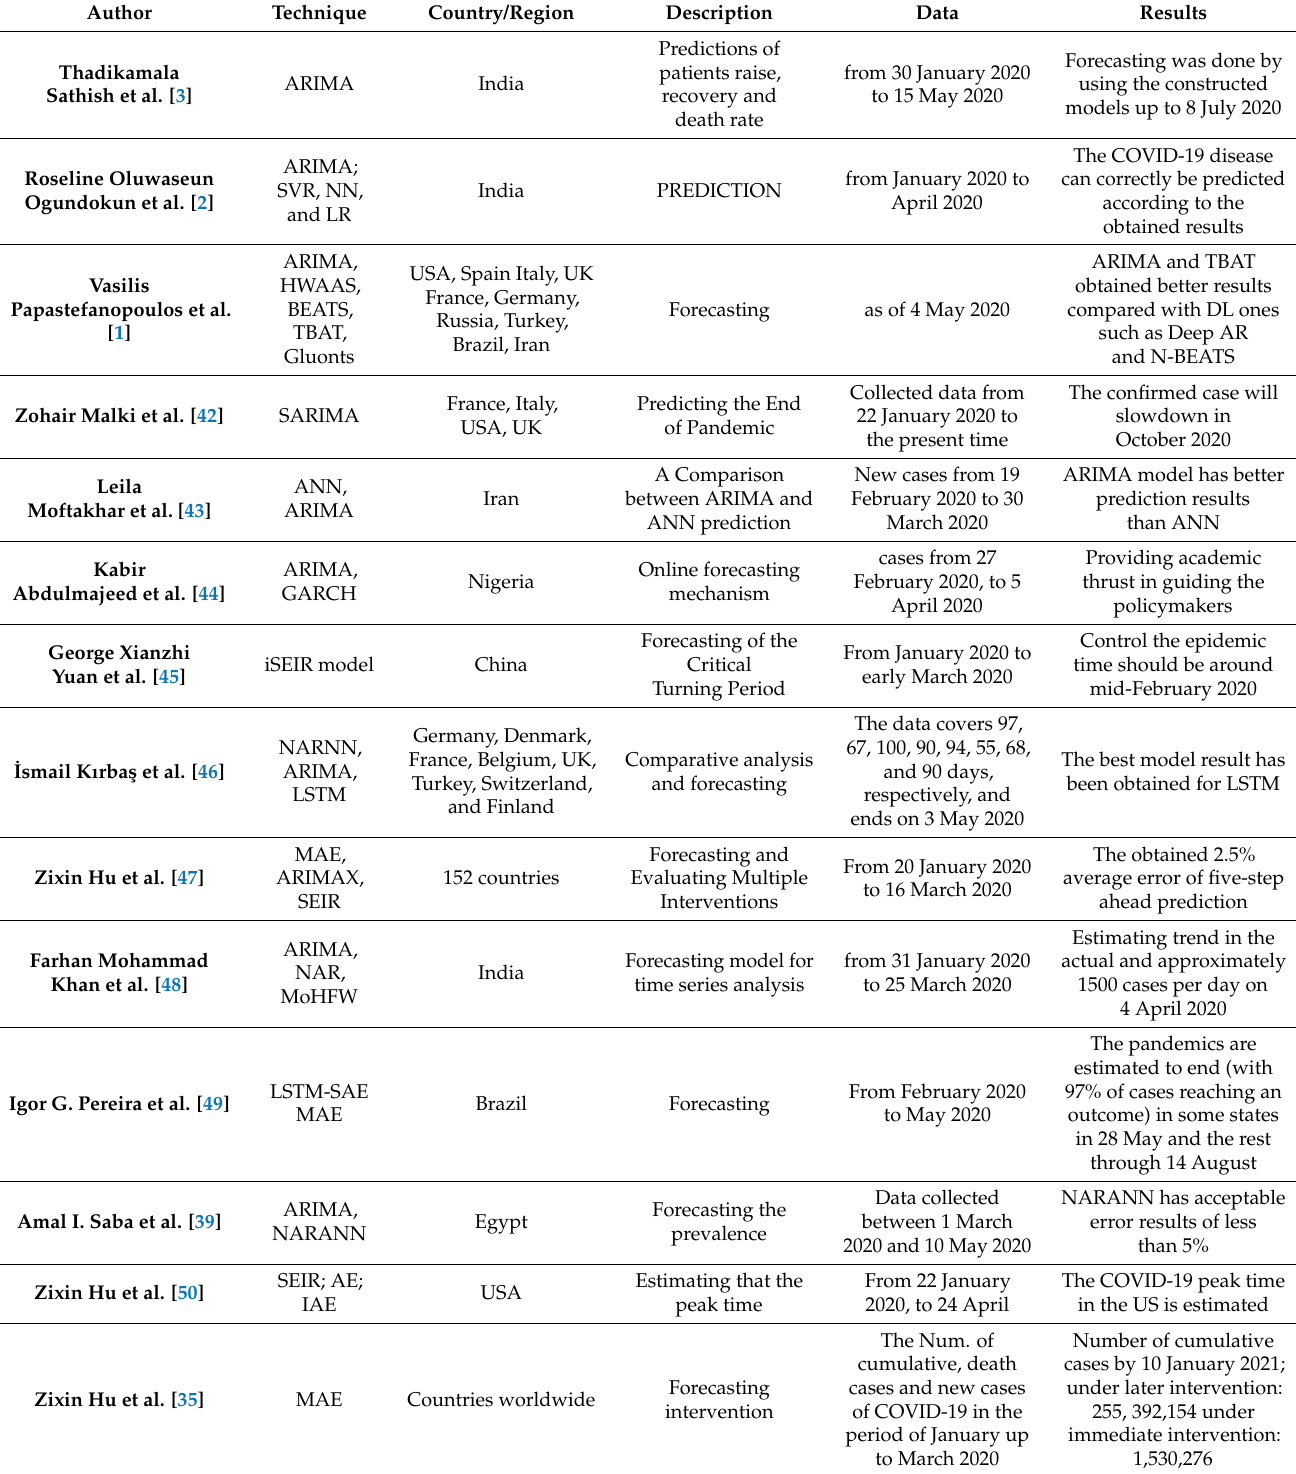
Table 1. Combination of AI techniques to enable ARIMA, SEIR, MAE, SAE, and SARIMA methods for forecasting COVID-19